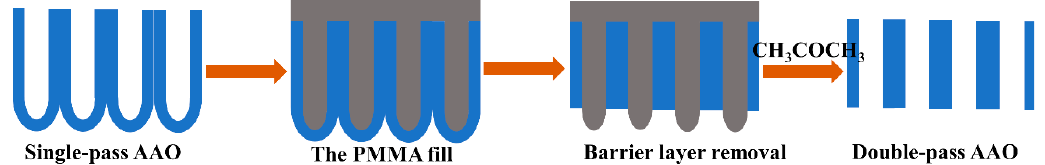
Figure 6. Schematic diagram of the barrier layer removal by using the PMMA colloid.